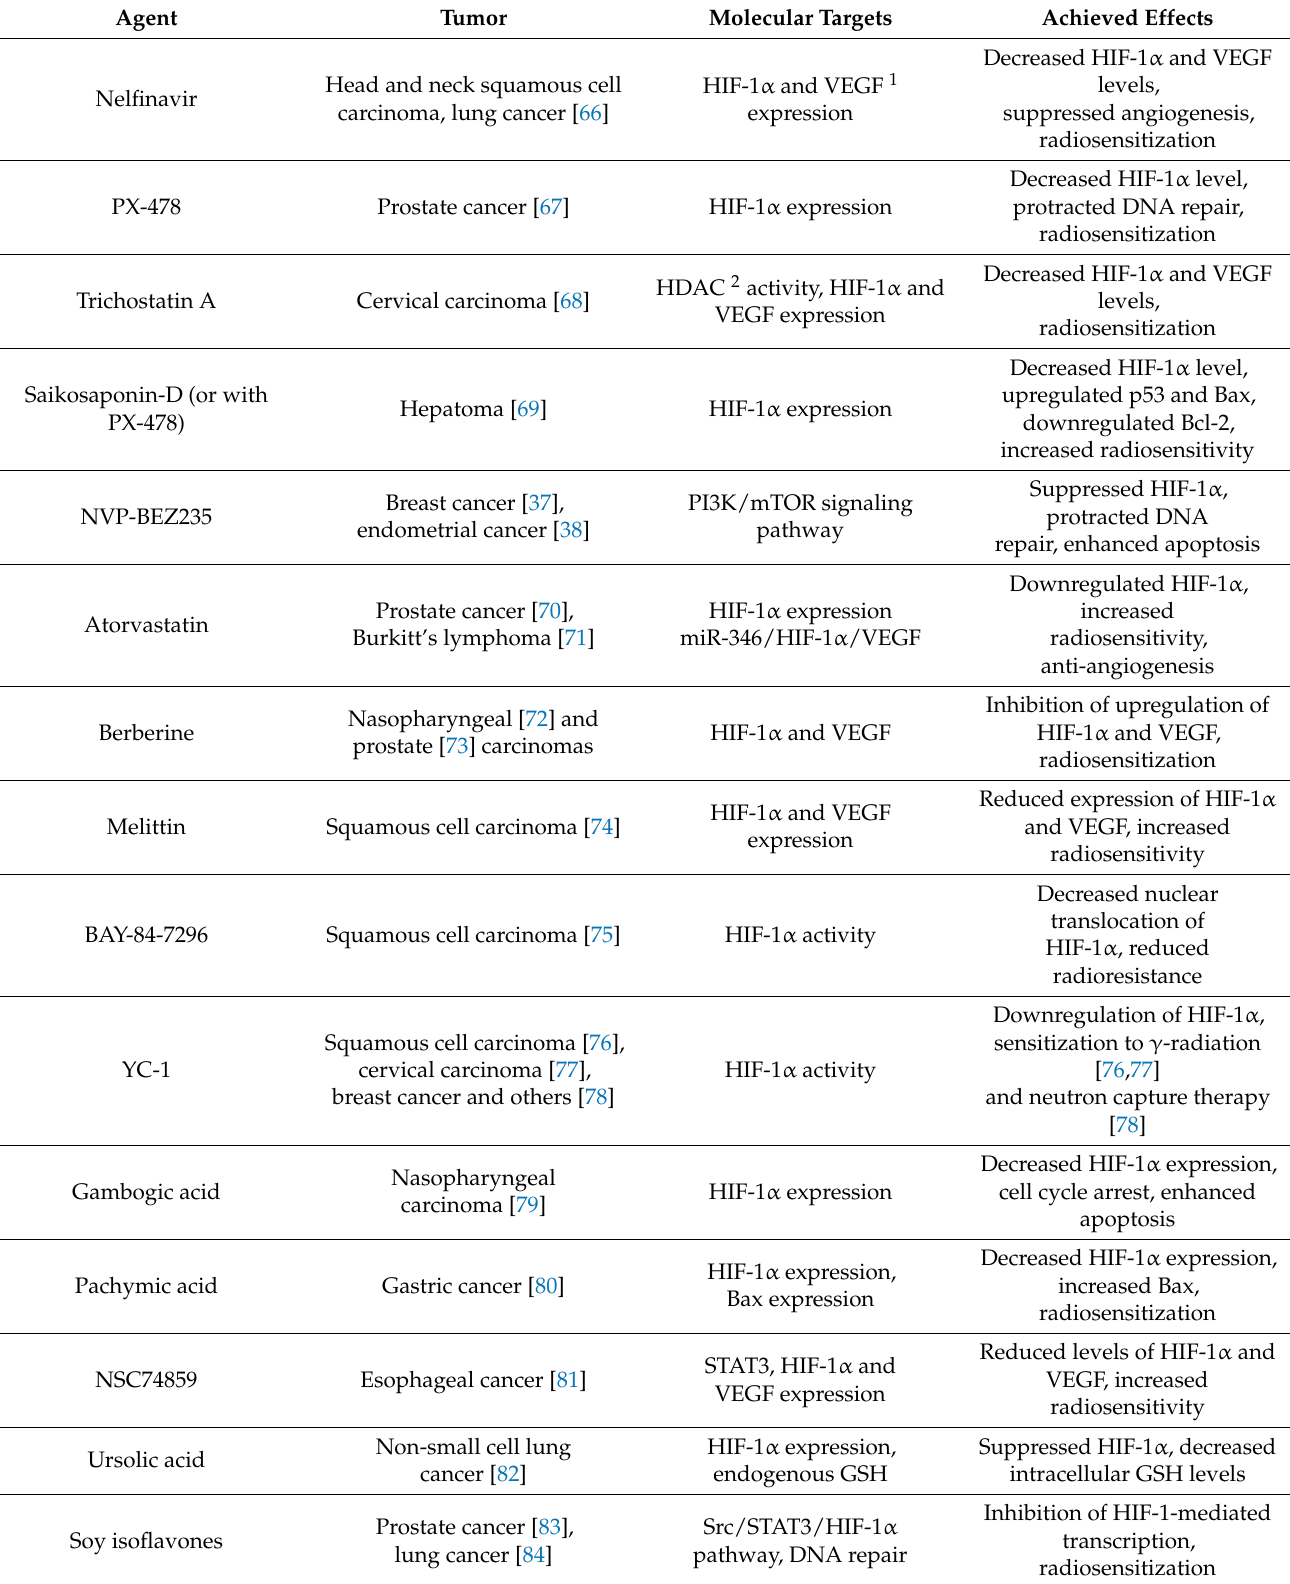
Table 1. Small molecule agents impairing the HIF-1-based radioresistance of tumor